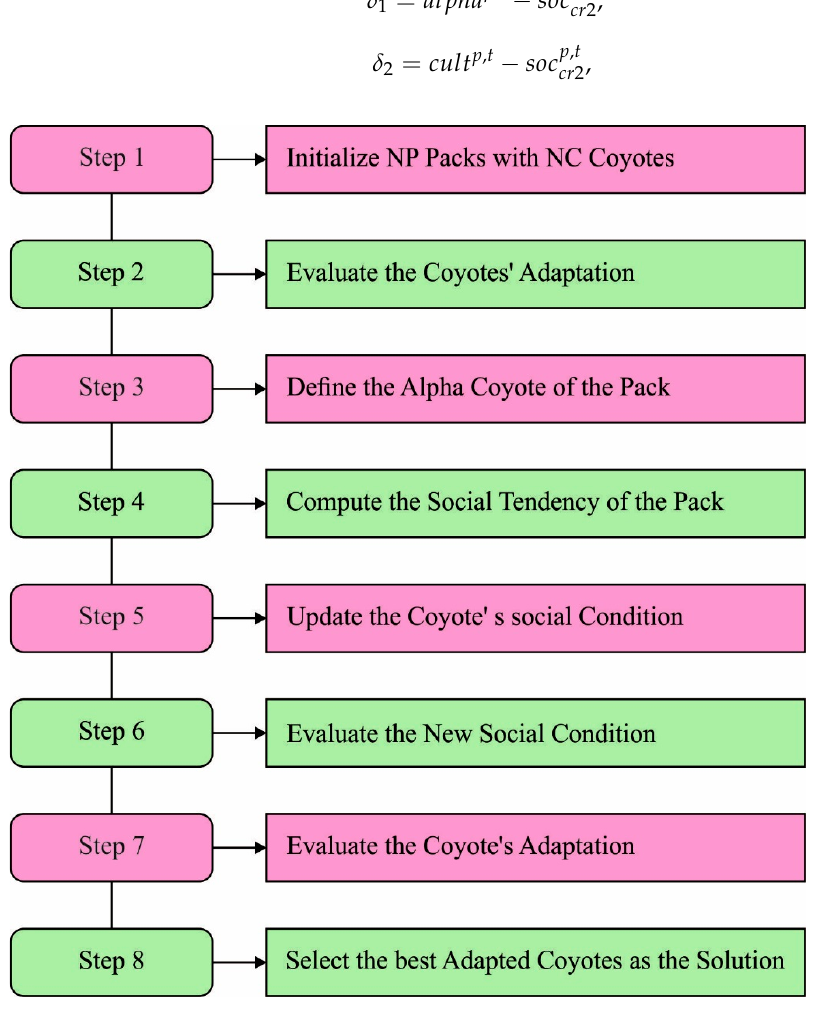
Figure 3. Flowchart of COA.